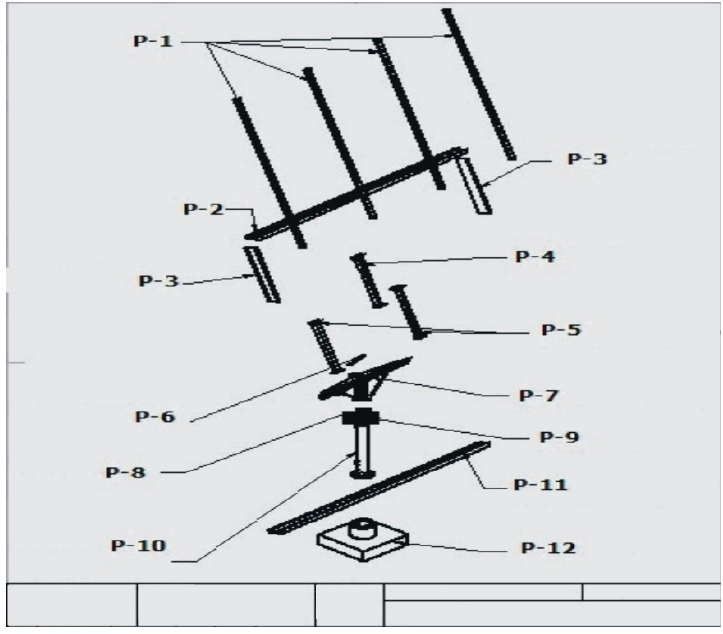
Figure 10. Mechanical plan for the proposed structure.